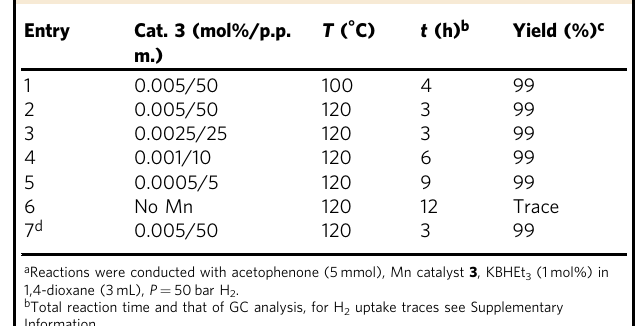
Table 2 Manganese-catalyzed hydrogenation of acetophenone with KBHEt 3 promotor a